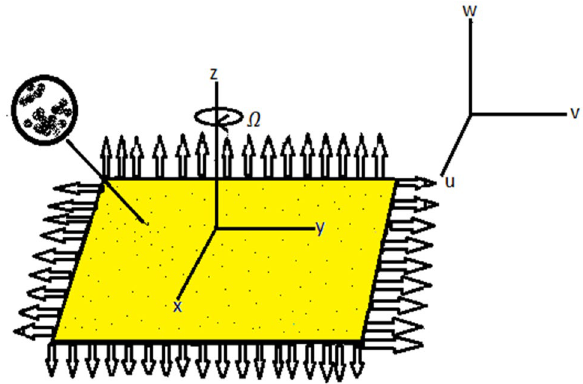
Figure 1. Geometry of the